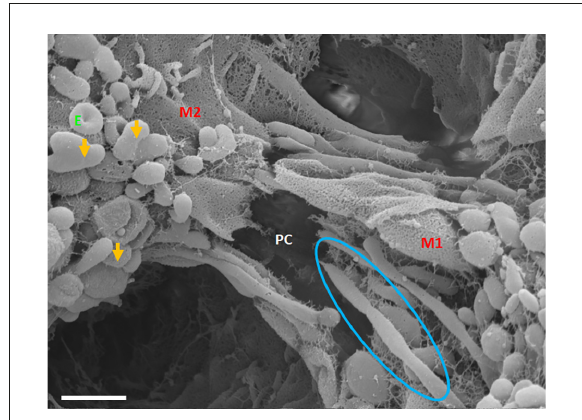
FIGURE8 An HR-SEM micrograph exhibiting long, tunneling NTs (TUNTs) extending within the paracellular space between adjacent bEnd5 cells. TUNTs form extensive close-ended intercellular cross-bridges between cell membranes 1–2 (M1-M2). Notice the indented nodes along the length of the TUNT indicating the zones of fusion between TF-exosomes. M1 and M2 denote the porous membranes on which the TUNT originates (M1) and the target cell membrane (M2) and PC denotes the paracellular space, E denotes surface exosomes, the orange arrows denote individual Es, and the blue circle denotes primordial TUNT formation from E fusion. Scale bar = 1,000 nm.